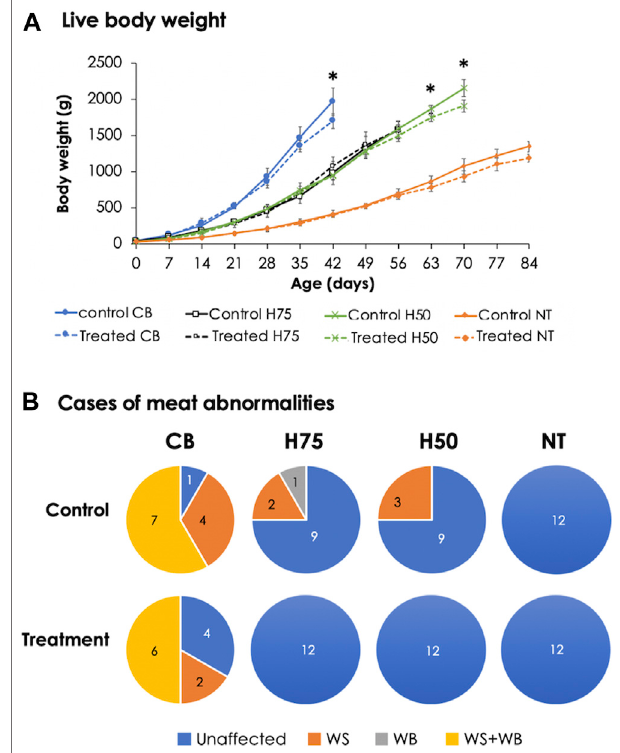
FIGURE 1 | Live body weight and cases of meat abnormalities in the chickens from different breeds. The birds were reared at a constant temperature (control, 26 ° C) or received heat challenge (treatment, 35 ° C, 6 h daily) for 20 days before reaching their market ages. (A) Markers and error bars depict average and standard deviation of live body weight ( n = 12 per group), respectively. (B) Venn diagrams illustrate occurrence of growth- related myopathies, including white striping (WS) and wooden breast (WB), in breast muscles ( n = 12 per group). CB: commercial broilers; H75: crossbreeds,75%broilerbackgroundand25%Thainativebackground;H50: crossbreeds, 50% broiler background and 50% Thai native background; NT: Thai native